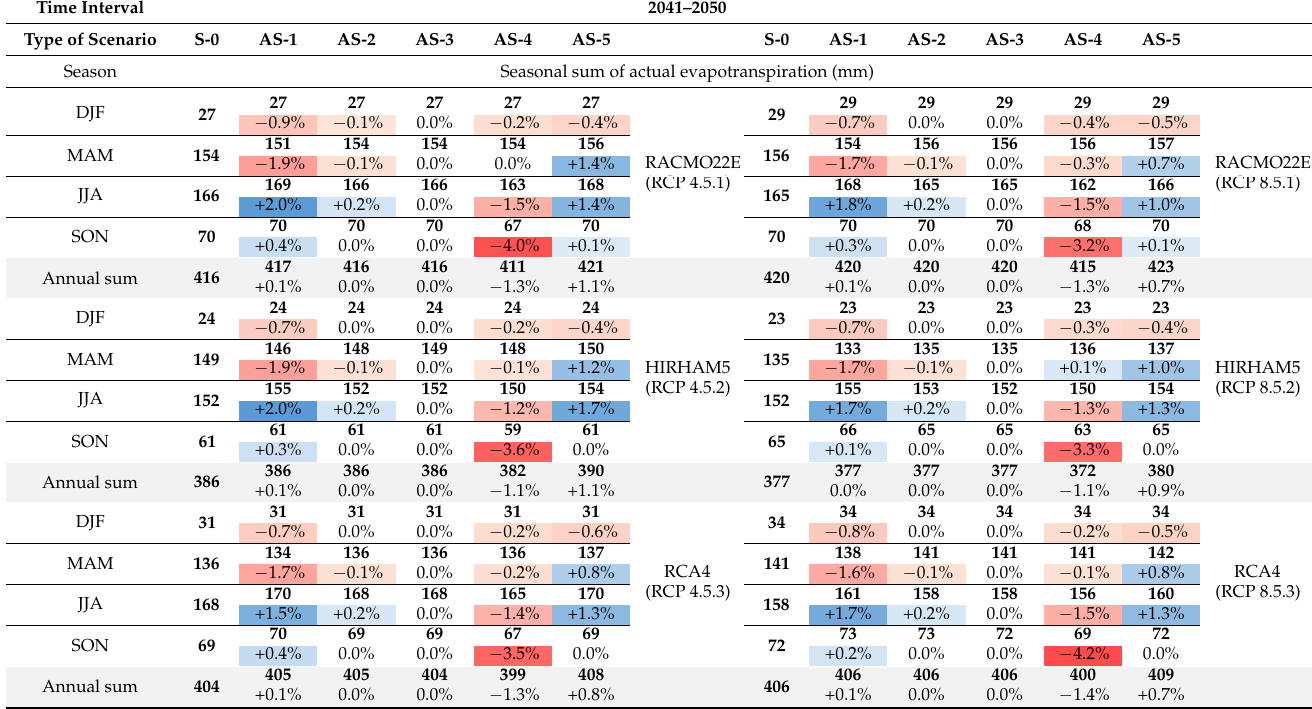
Table 9. Comparison of seasonal actual evapotranspiration between scenario 0 (S-0) and adaptation scenarios 1–5 (AS-1, AS-2, AS-3, AS-4, AS-5) for 2041–2050 in the Bystra catchment for climate soil water content and shaded numbers indicate percentage changes (red indicates % decrease in content, and blue indicates % increase in content). Dark red and dark blue shading indicates large changes, while light red and light blue shading indicates small changes (own